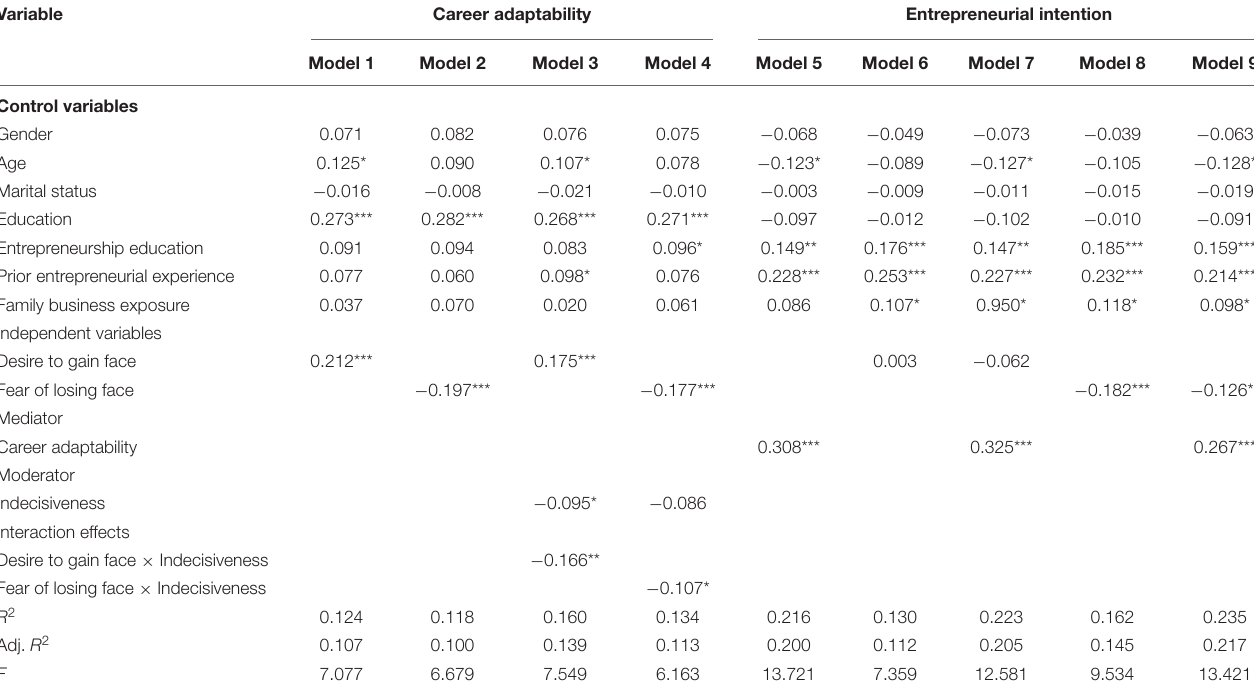
TABLE 3 | Results for the hierarchical regression analysis of direct, mediator, and moderator effects. Variable